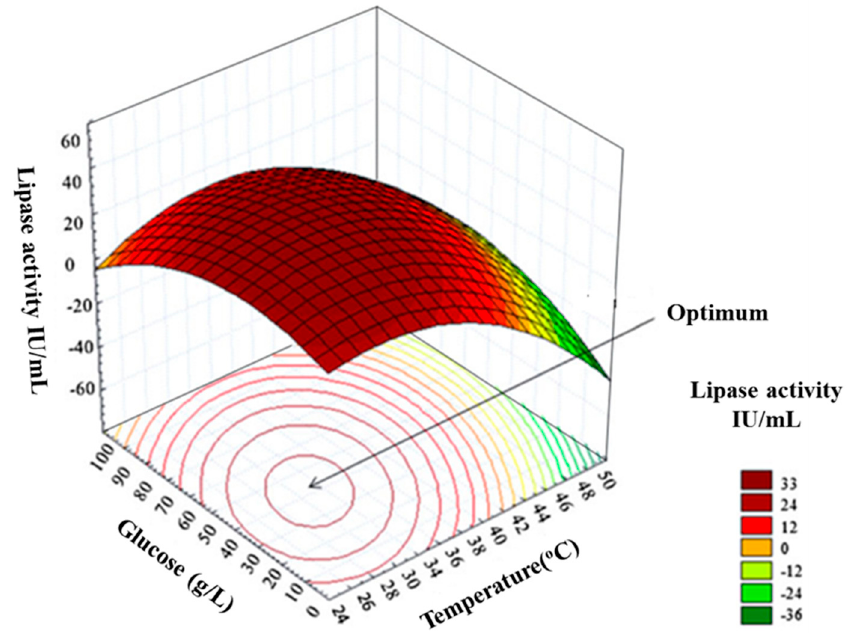
Figure 7. An example of response surface and contour plot adapted from Nelofer et al., 2012 [163]. The figure depicts the two-factor interaction (in this case the two factors explored are glucose and culturing temperature) where one factor influences the response of another factor. It also shows the visualisation of optimum levels. The colour scale indicates the level of lipase activity (IU/mL) where red indicates the region of optimal yield, yellow indicates medium yield, and green indicates low yield. In this case, the optimal enzyme activity (33 IU/mL) was achieved at a culture temperature between 30 °C and 34 °C; and a glucose concentration between 40 g/mL–50 g/mL. Image used with permission.